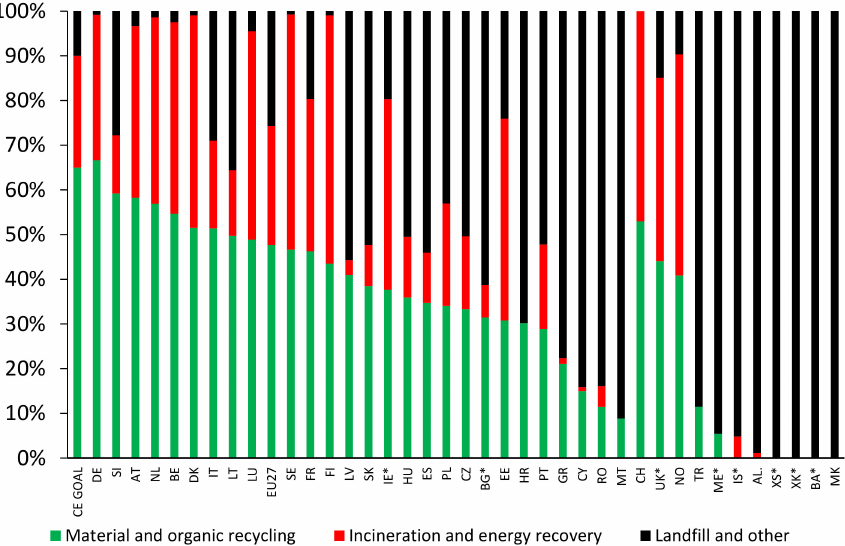
Figure 1. Methods of municipal waste management in European countries, * data from 2018; source: Eurostat database